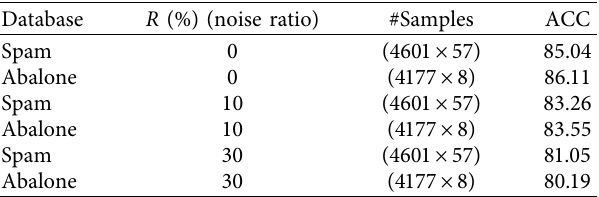
Table 6: Performance measures of